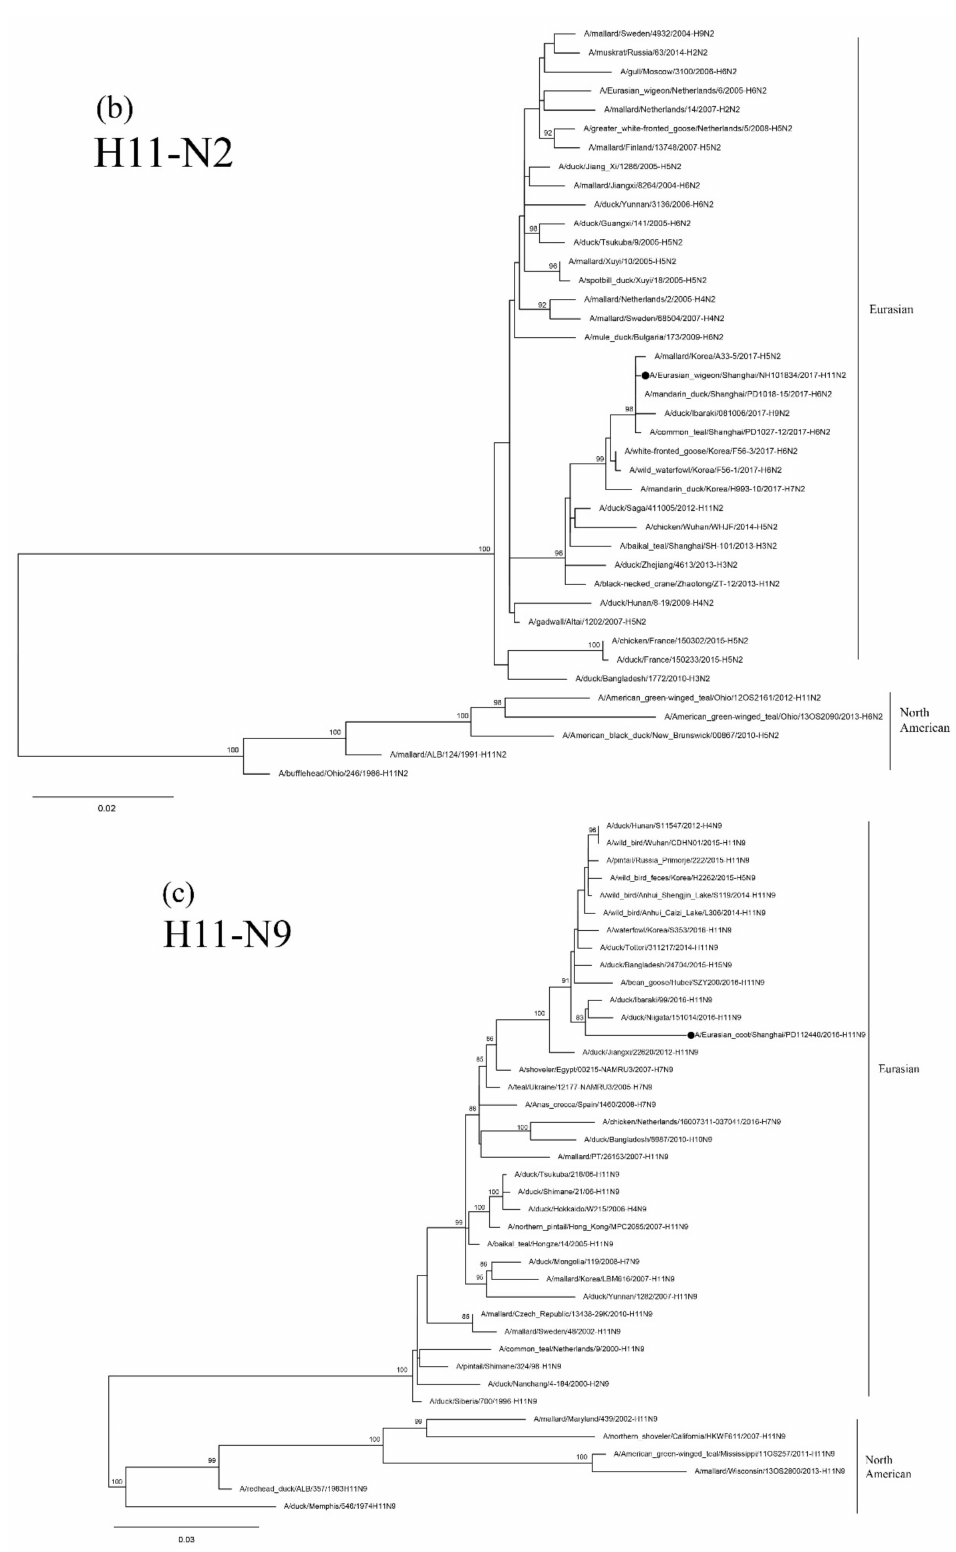
Figure 3. Phylogenetic trees of HA ( a ), N2 ( b ), and N9 ( c ) genes of the H11 isolates found in Shanghai, China. HA, N2 and N9 genes are 24–1688 bp, 29–1394 bp and 1–1413 bp, respectively. The maximum-likelihood (ML) trees were constructed using the TIM1 + G model for HA and N2 genes and the GTR + G model for N9 genes in PhyML software version 3.0. Bootstrap values were calculated for 100 replicates. Values less than 75% are not shown. Numbers indicate ML bootstrap values. H11 AIV isolates characterized in this study are indicated with black